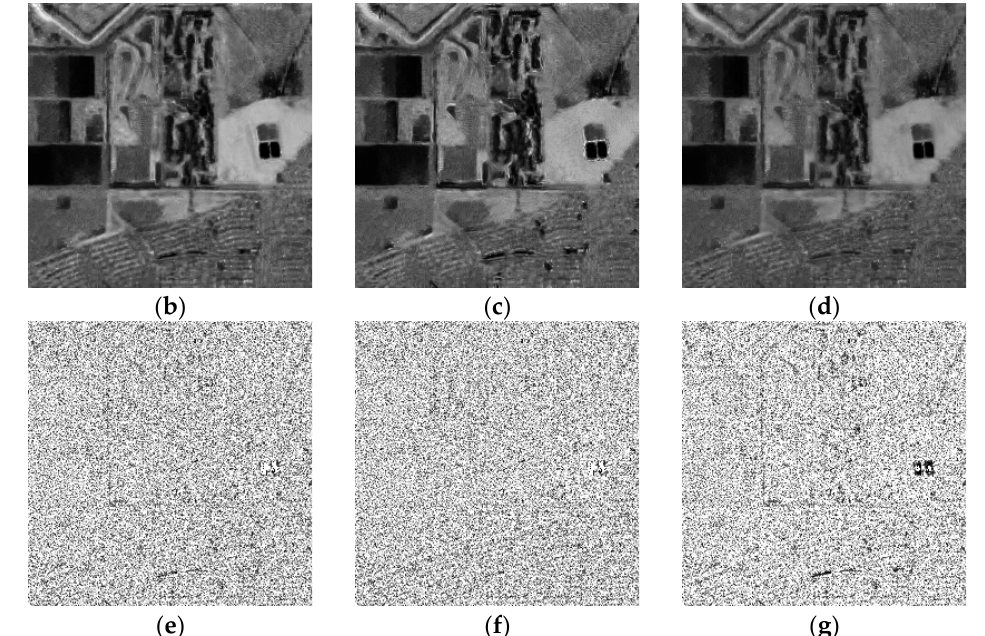
Figure 7. The results of the candidate combinations on S2 ( L = 1), and the bottom row are the corresponding ration images. ( a ) Noisy image; ( b ) Fusion #1; ( c ) Fusion #2; ( d ) Fusion #3; ( e ) Fusion #1; ( f ) Fusion #2; ( g ) Fusion #3.